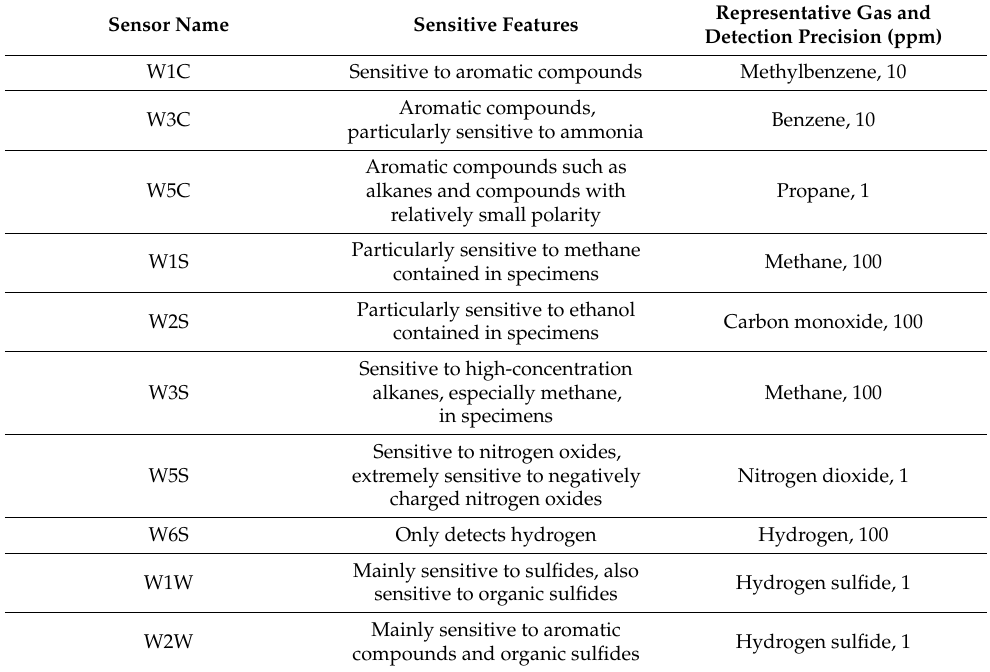
Table 2. Names of sensors in the PEN3 electronic nose sensor array, their sensitive gas and detection